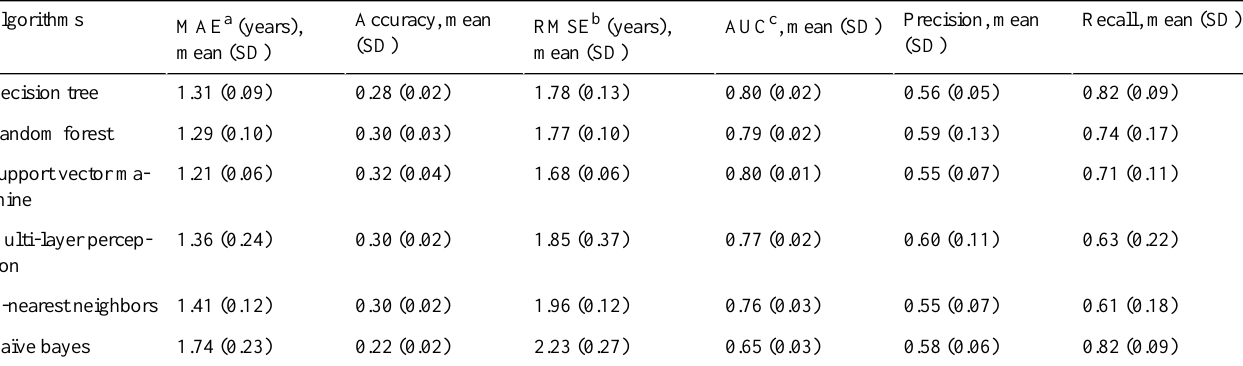
Table 13. Mean (SD) of the performance metrics, for the female subjects’classification models.